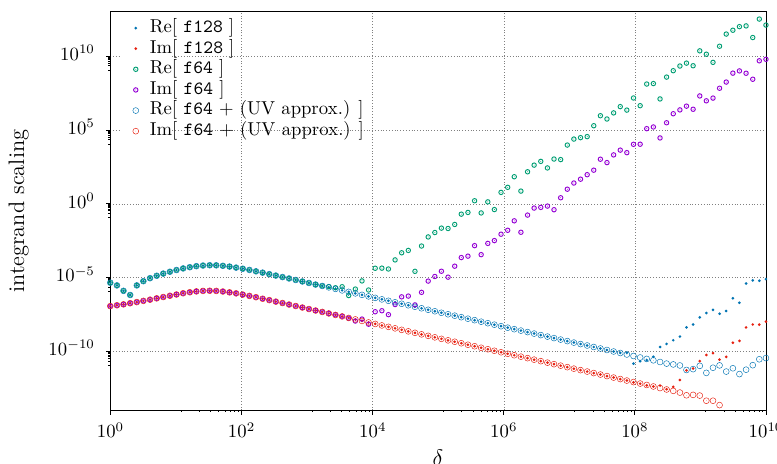
Figure 17. Behaviour of numerical instability in the UV due to imprecise cancellations between large numbers from each each dual integrand. The loop momentum k is rescaled by a factor (cid:14) and the real and imaginary part of the amplitude are presented with di(cid:11)erent precision (double and quadruple) and by expanding the expression around the UV limit as an approximation (see section